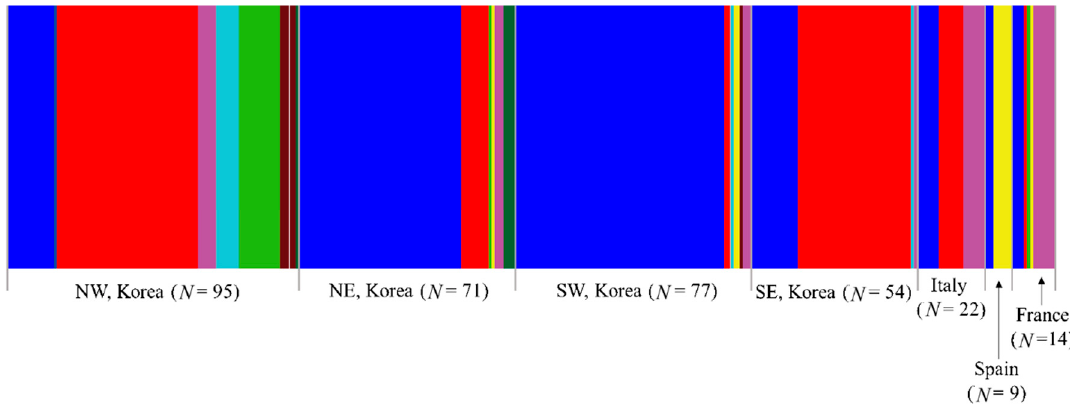
Figure 5. Clustering using Bayesian Analysis of Population Structure (BAPS) of the 342 individuals of Metcalfa pruinosa based on country/Korean region using concatenated sequences of the DNA barcoding region (658 bp) and Region 5. The optimal number of clusters ( K ) was eight.